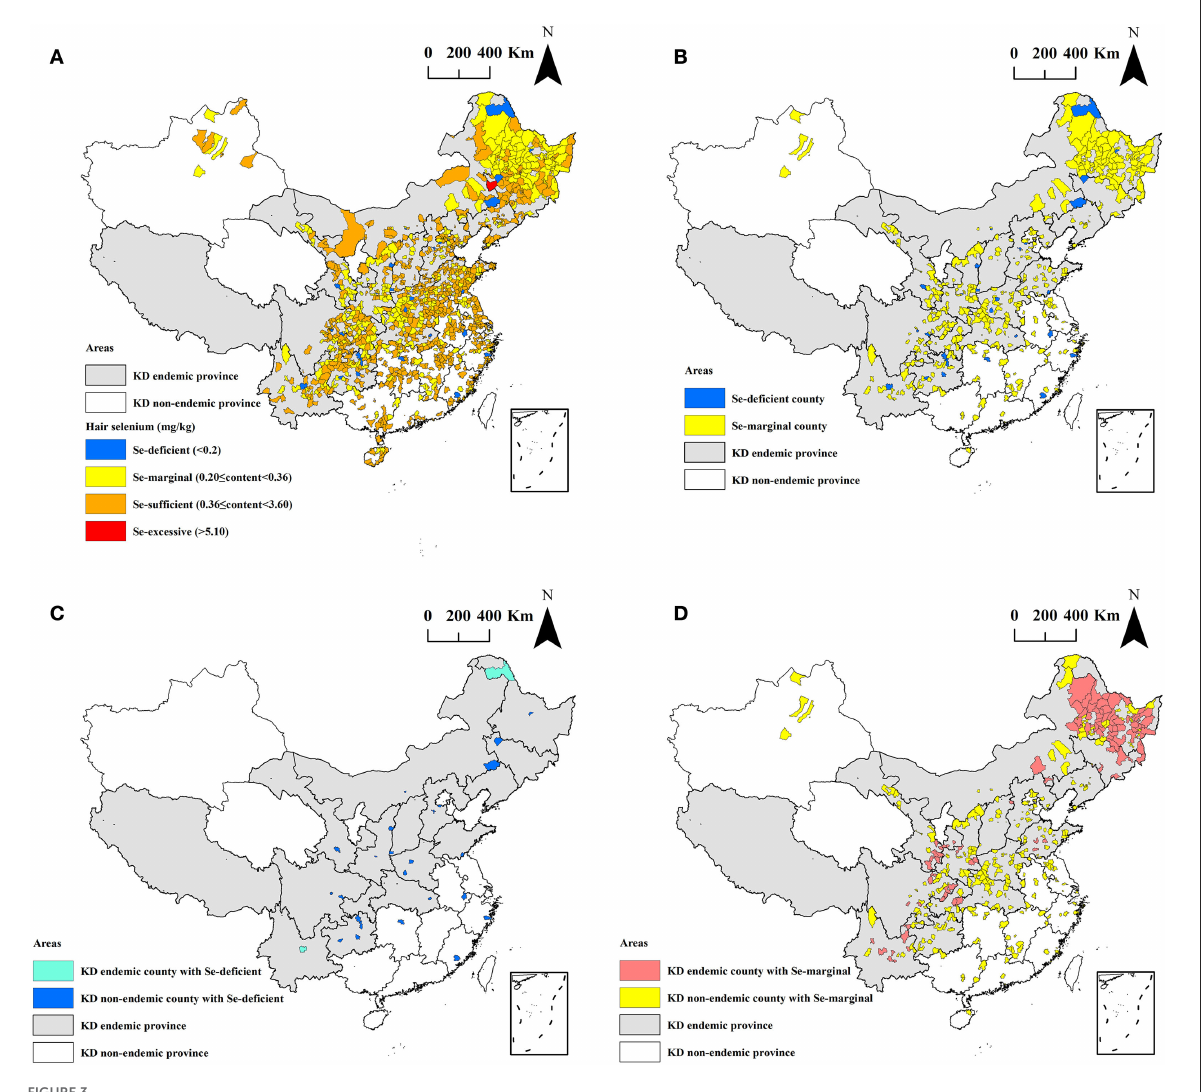
FIGURE3 The spatial distribution of the hair selenium levels at the county level. (A) All 1,174 counties; (B) Se-deficient and Se-marginal counties; (C) Se-deficient counties; and (D) Se-marginal counties.